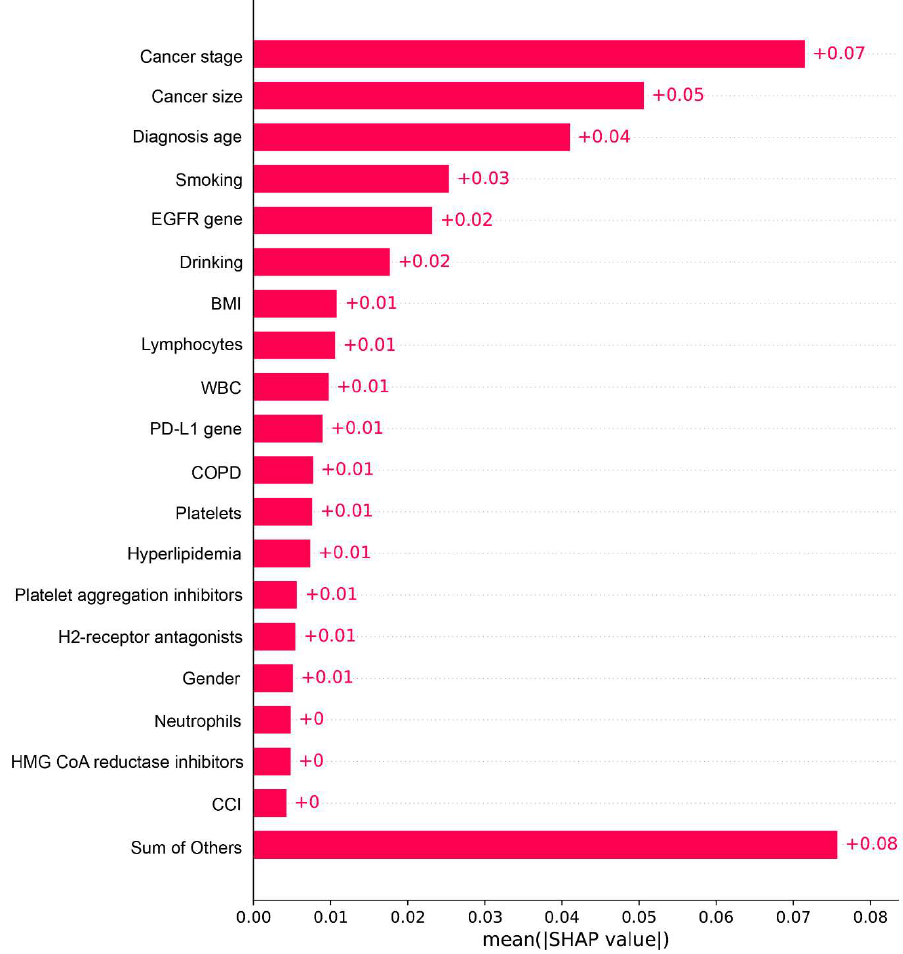
Figure 3. Feature Importance of the ANN Prediction Model in Mode 4. Note : BMI, Body mass index; EGFR, Epidermal growth factor receptor; WBC, White blood cell; PD-L1, Programmed death-ligand 1; COPD, Chronic obstructive pulmonary disease; CCI, Charlson comorbidity index.